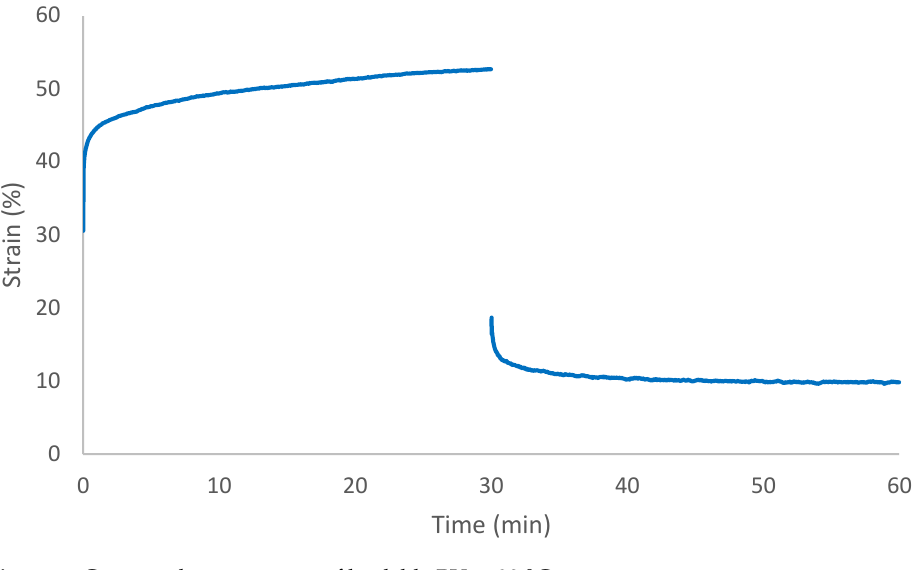
Figure 5. Creep and recovery test of healable PU at 90 °C.